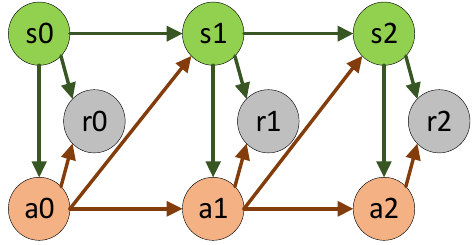
Figure 2. Markov chain.